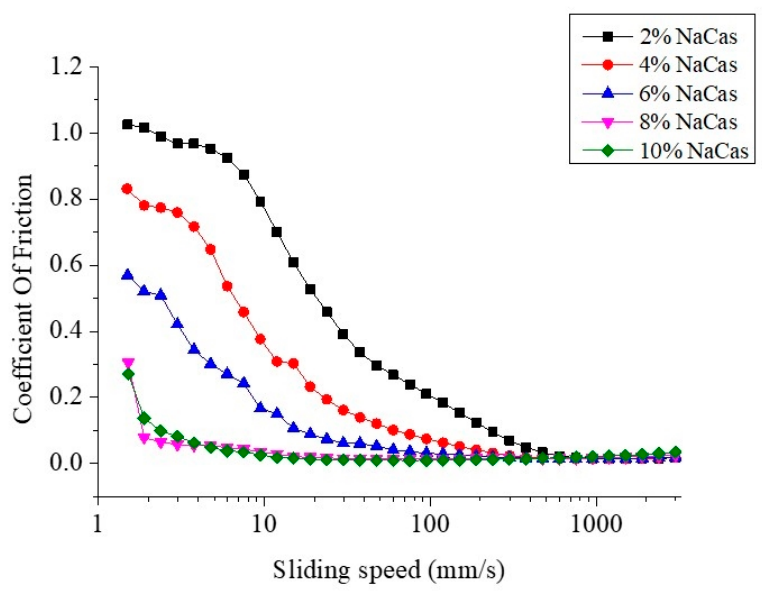
Figure 5. Friction coefficient of S/O/W emulsions at different concentrations of NaCas and 5% proportions of the S/O phase was measured by a tribometer at 37 °C simulated oral rejection.